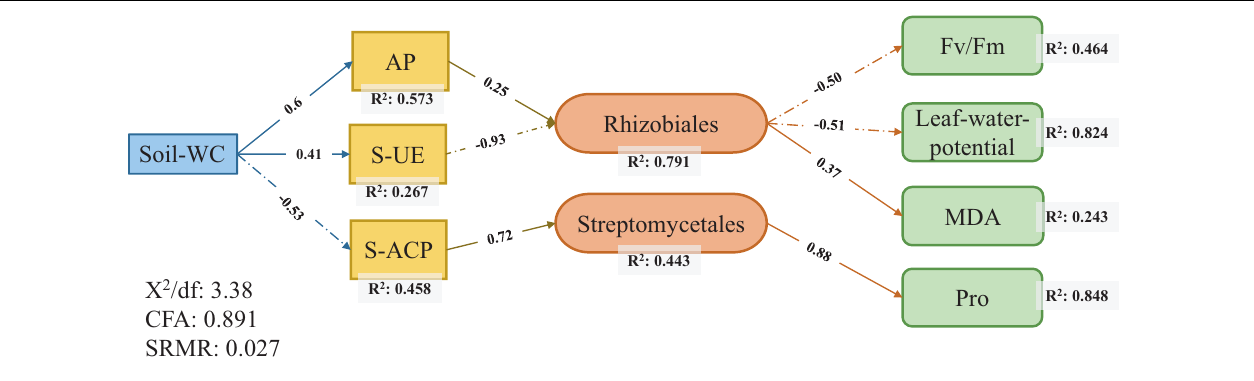
FIGURE 5 | Structural equation modeling of the relationship between core responsive bacteria and soil environment and sugarcane physiology under drought stress.